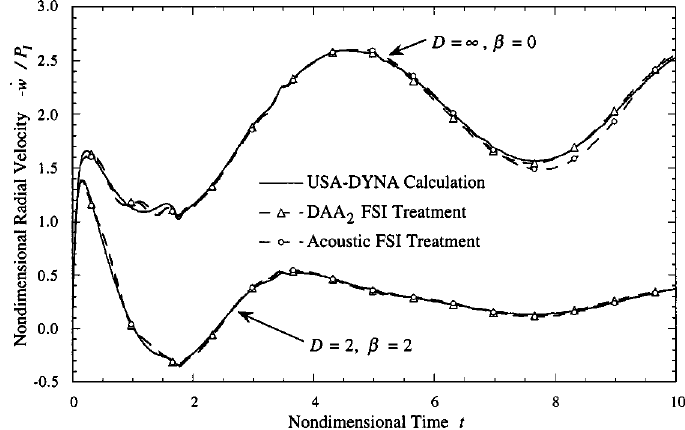
Fig. 11. Shell radial-velocity histories at (cid:18) = (cid:25) for an empty spherical shell excited by a plane step wave ( D = 1 , (cid:12) = 0) and a spherical step-exponential wave ( D = 2, (cid:12) = 2); N = 7.